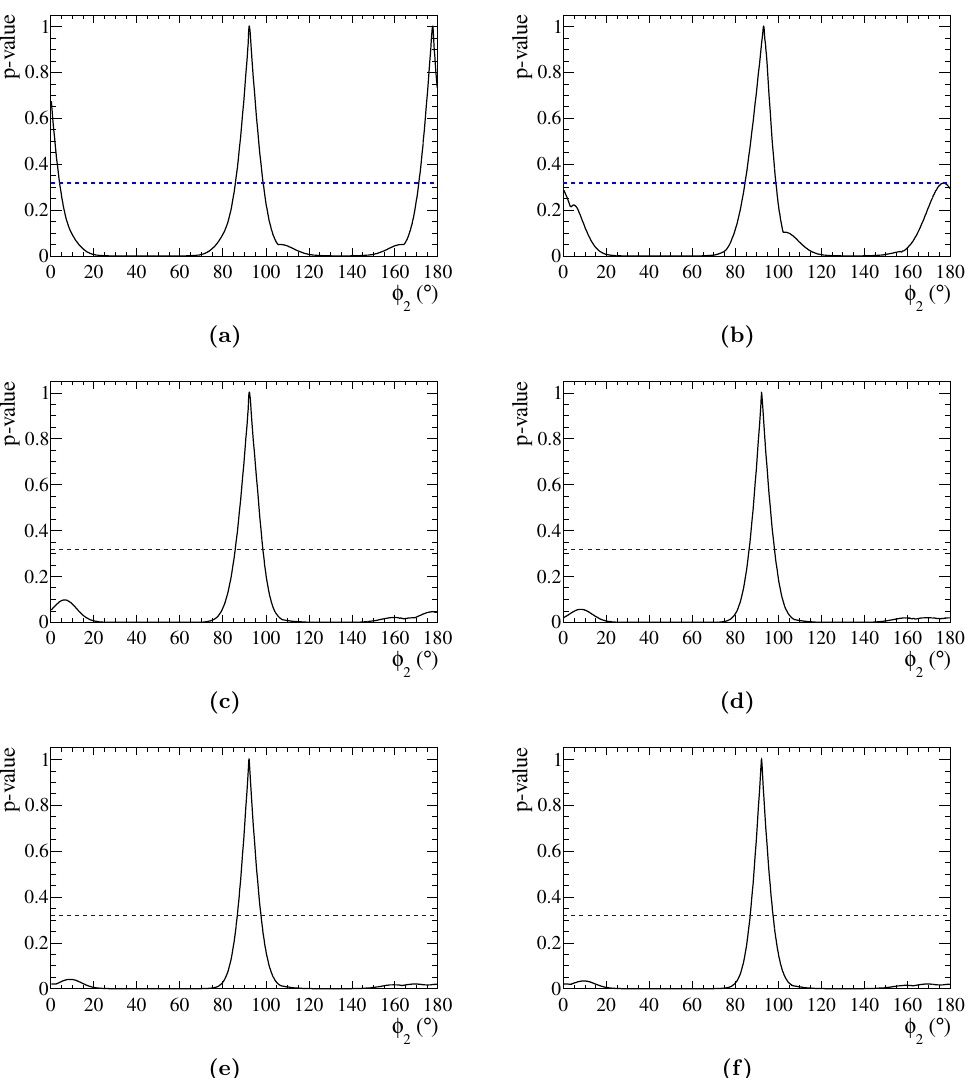
Figure 3 . p -value scans of (cid:30) 2 where the horizontal dashed line shows the 1 (cid:27) bound. (a) shows the standard scan involving the quasi-two-body-parameters for B 0 ! (cid:26) 0 (cid:26) 0 obtained by the BaBar Collaboration. The remaining scans show the e(cid:11)ects of increasing separation between the two solutions for (cid:30) 00 from 1 (cid:27) -5 (cid:27) , where their uncertainties are scaled to (b) (cid:14)(cid:30) 00 = 50 : 8 (cid:14) (c) (cid:14)(cid:30) 00 = 2 2 2 25 : 4 (cid:14) (d) (cid:14)(cid:30) 00 = 17 : 0 (cid:14) (e) (cid:14)(cid:30) 00 = 12 : 7 (cid:14) and (f) (cid:14)(cid:30) 00 = 10 : 2 (cid:14) . 2 2 2 between the two solutions of (cid:30) 00